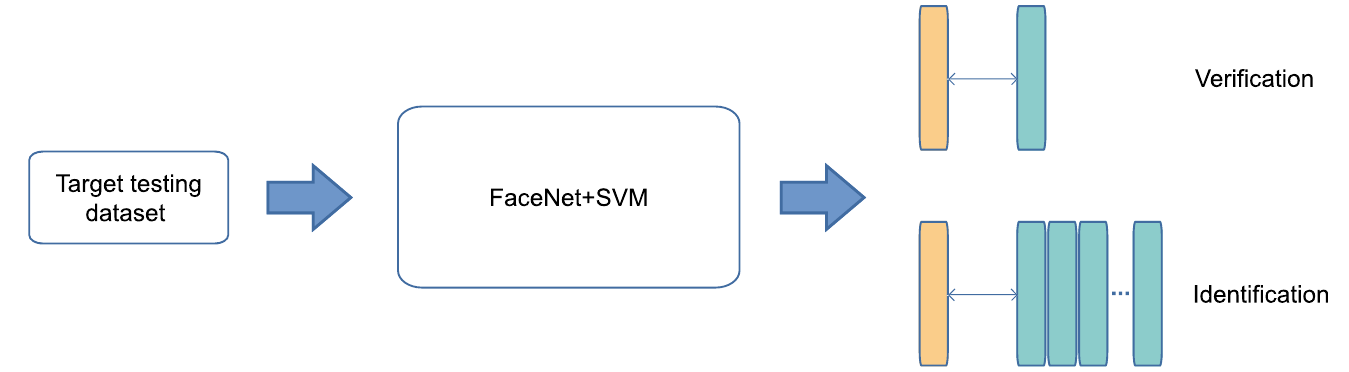
Figure 6. The testing of the proposed FaceNet+SVM